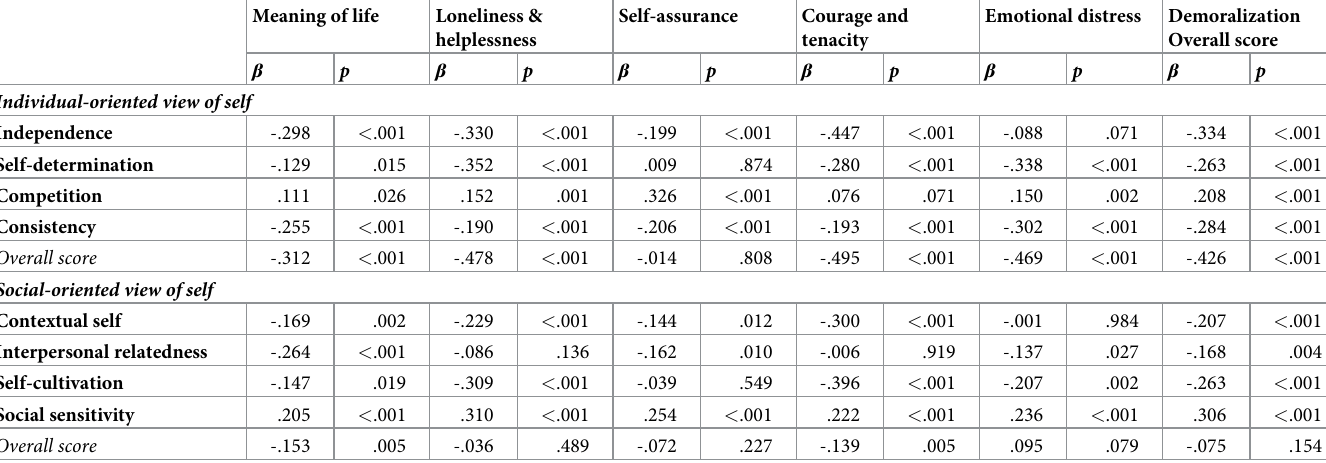
Table 4. Association between demoralization score and individual-oriented self (ISS-I)/social-oriented self (ISS-S) among 356 participants. Meaning of